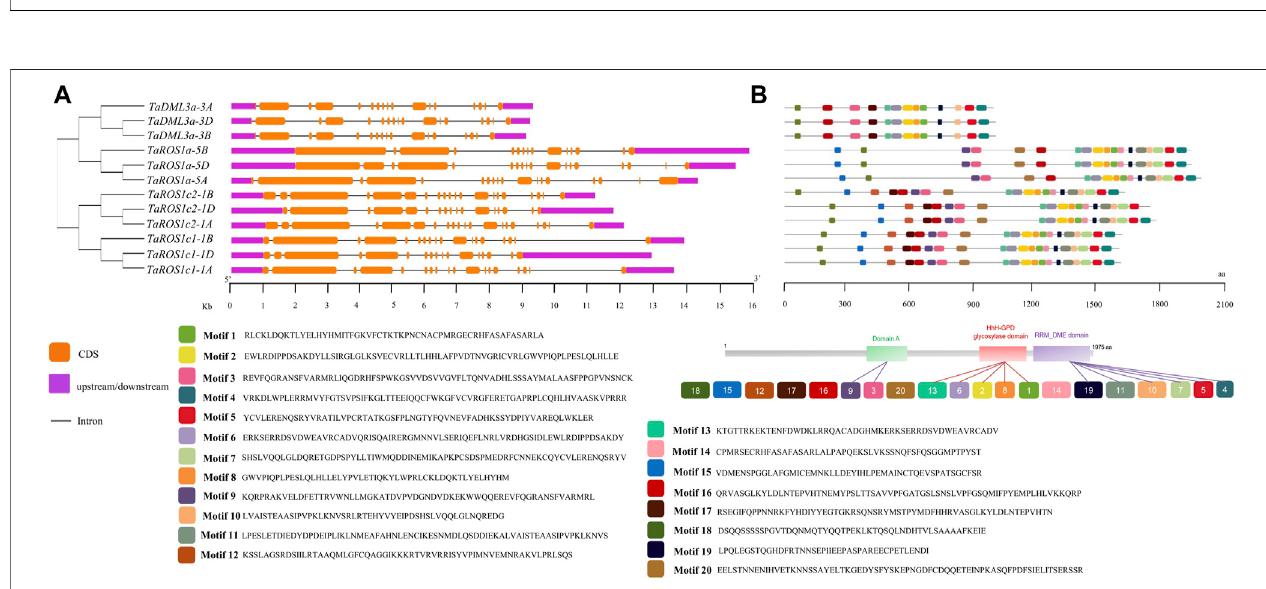
FIGURE2| Exon-intronstructuresand conserved motifcompositionsofTadMTases. (A) Exon – intron structures of TadMTase genes.Exonsareshown asorange boxes, introns are denoted by thin dark grey lines, and upstream/downstream regions are shown as purple boxes. The lengths of exons and introns can be determined using thescalebaronthebottom. (B) Motifs organizationofTaDMTaseproteins. Colorboxesrepresentthepositionofdifferentmotifs, andbox sizesshow thelengthof motifs. Sequences for 20 different motifs were also provided on the right side.